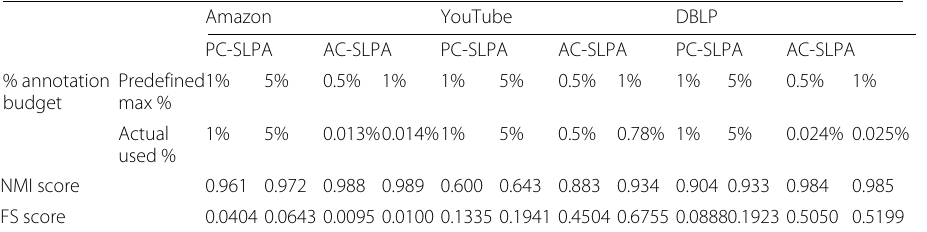
Table 6 Comparison of AC-SLPA and PC-SLPA on three real-world networks Amazon YouTube DBLP PC-SLPA AC-SLPA PC-SLPA AC-SLPA PC-SLPA AC-SLPA % annotation